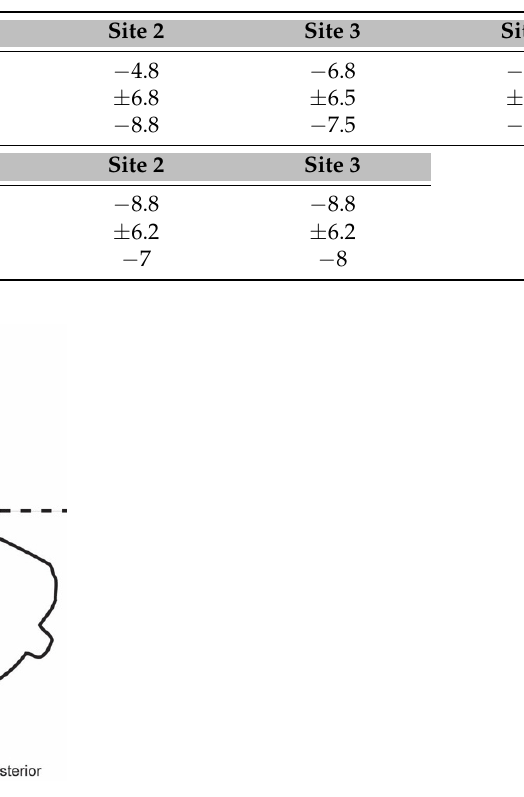
Figure 1. A schematic demonstration of the angle of entry used for MEC